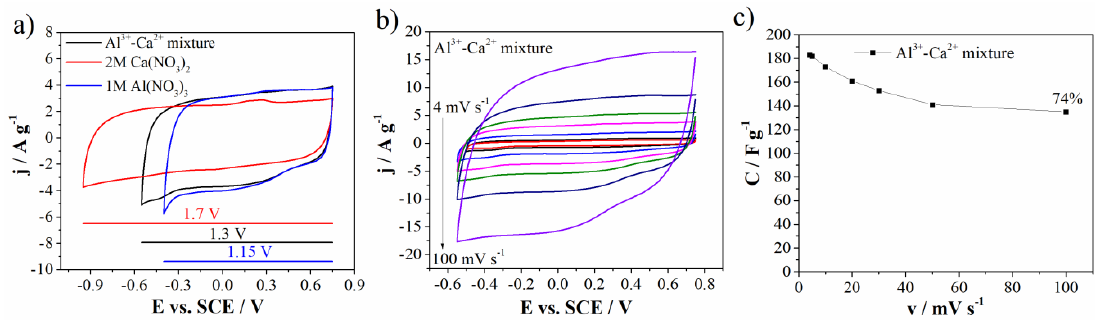
Figure 8. ( a ) CVs comparison of three electrolytes at 20 mV s − 1 , ( b ) CVs of Al 3+ -Ca 2+ mixture at various scan rates, and ( c ) capacitance value with retention for Al 3+ -Ca 2+